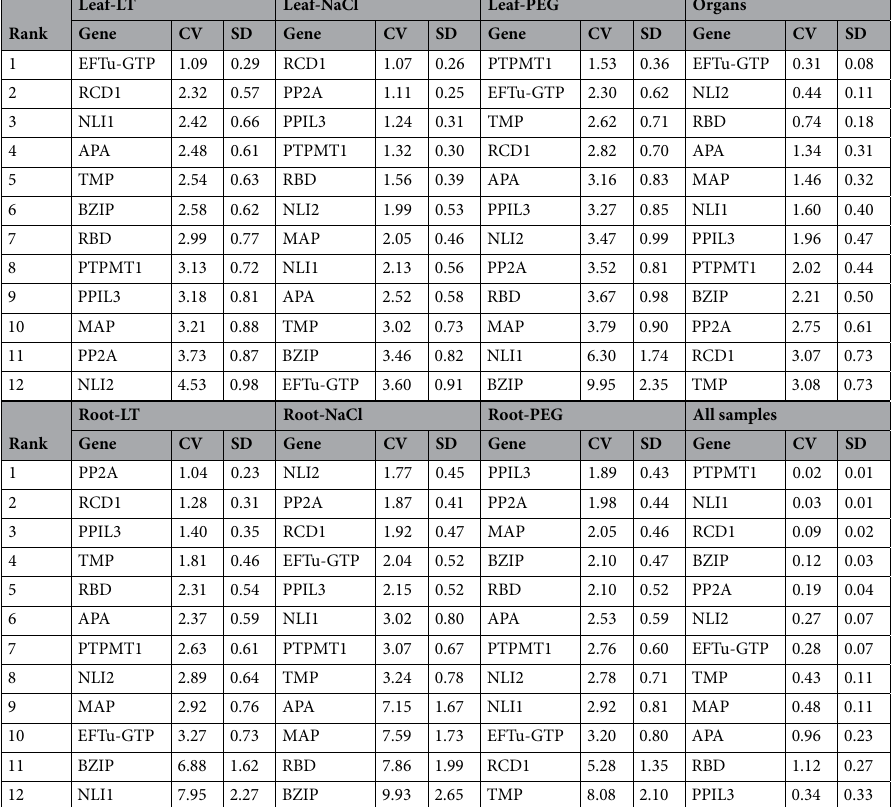
Table 4. Ranking of 12 candidate reference genes according to BestKeeper.